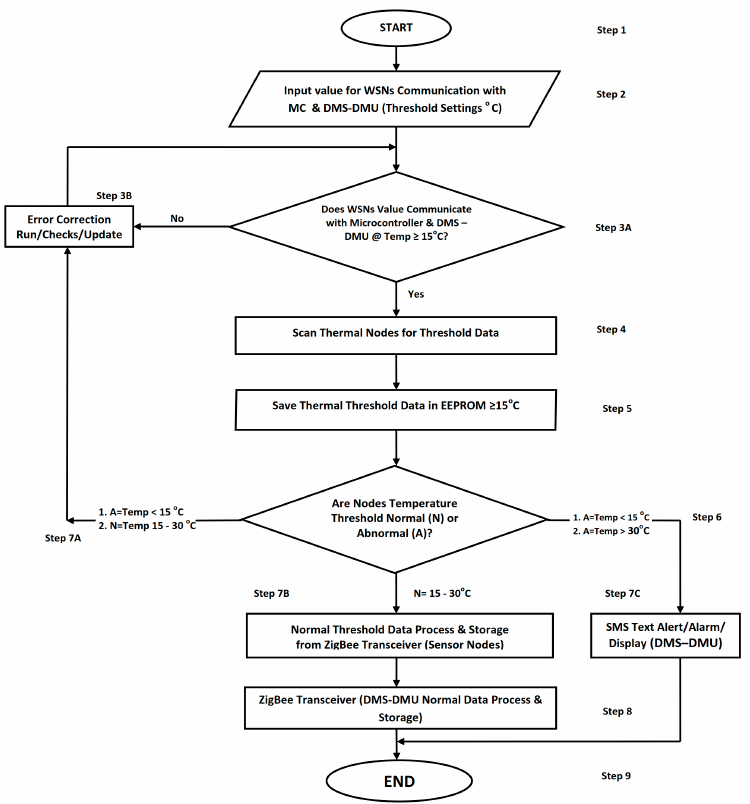
Figure 4. An algorithm flow chart.